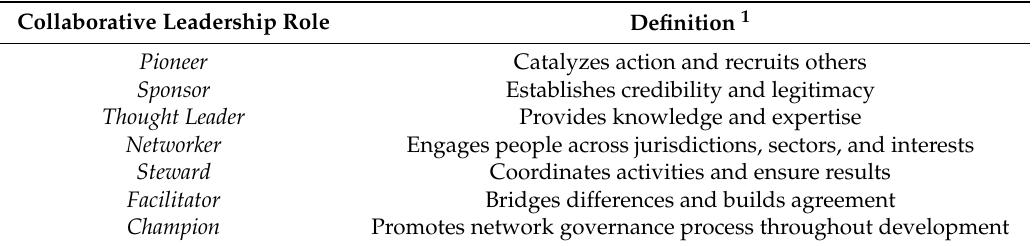
Table 2. Collaborative Leadership Roles and